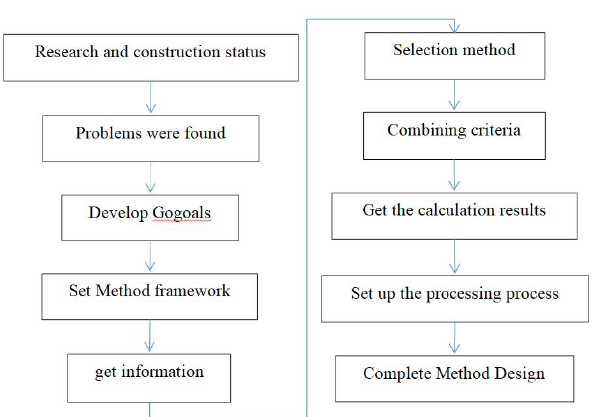
Fig. 1 Design process of college education informationisation assistance